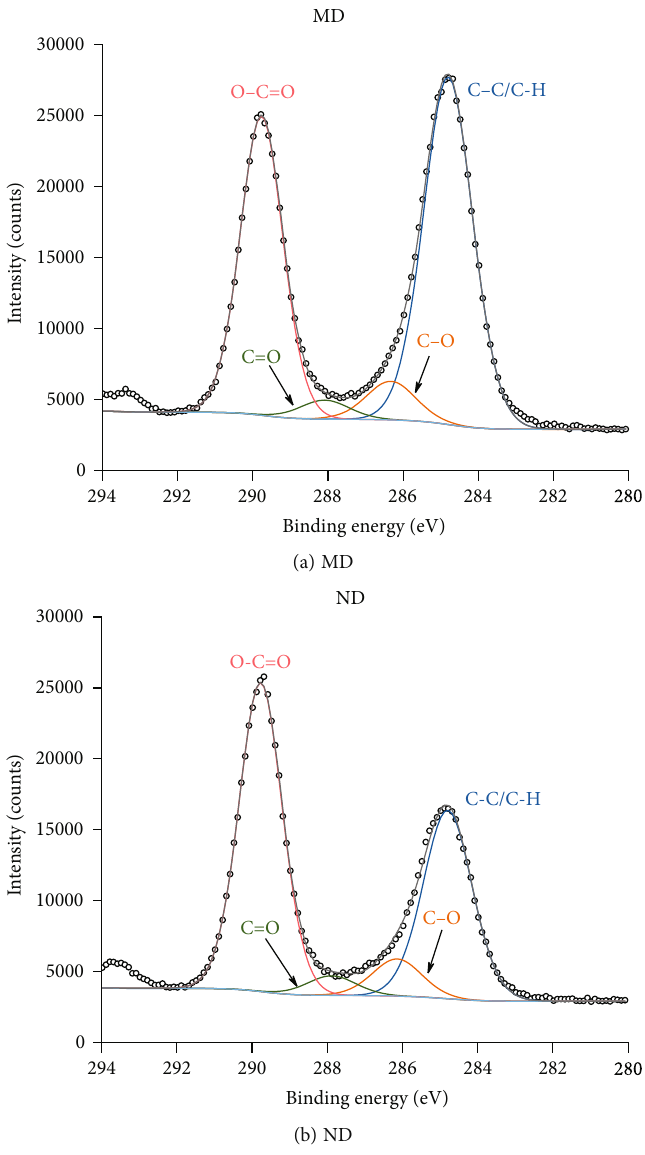
Figure 8: C(1s) XPS spectra of MD and ND surface. Table 5: The binding energy and percentage of the relative peak areas of the components on the dust surface of MD and ND obtained from XPS analysis of